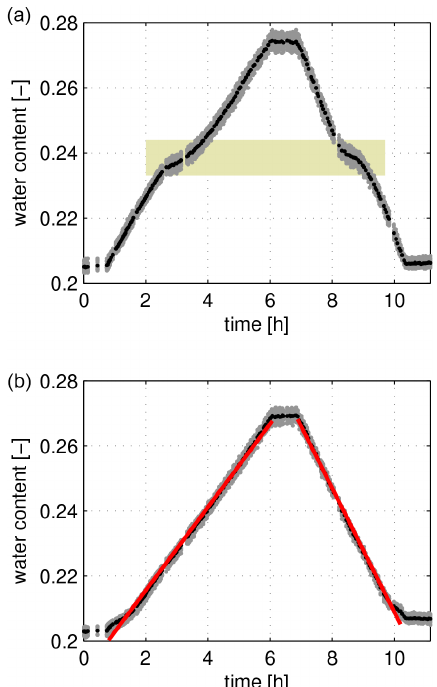
Figure 9. Transient shape of a dynamically varying transition zone above a capillary fringe for a two-layered medium consisting of AS- SESS sands A (lower layer) and C (upper layer) when subjected to the imbibition forcing of experiment 1. The solid black line indi- cates the equilibrium curve; the solid blue line denotes the transient shape just after the imbibition has been stopped. During imbibition, the transient state is marked every 0.2h by grey dashed lines. A comparison of the grey (blue) shaded areas denoting equal imbibi- tion intervals in both materials shows that the water content increase will proceed at an approximately constant but potentially different rate in both materials sufficiently far from the interface. At the in- terface, the shape of the capillary fringe has to adapt, leading to a slower increase rate of the water content, as has been observed in Fig.